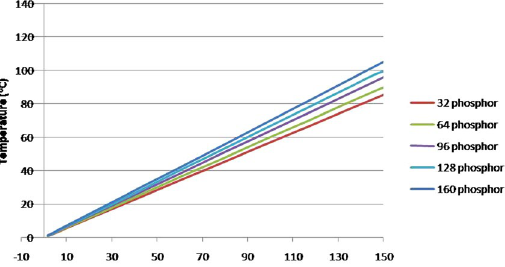
Figure 11. The temperature rise comparison between different samples with varying phosphor particle